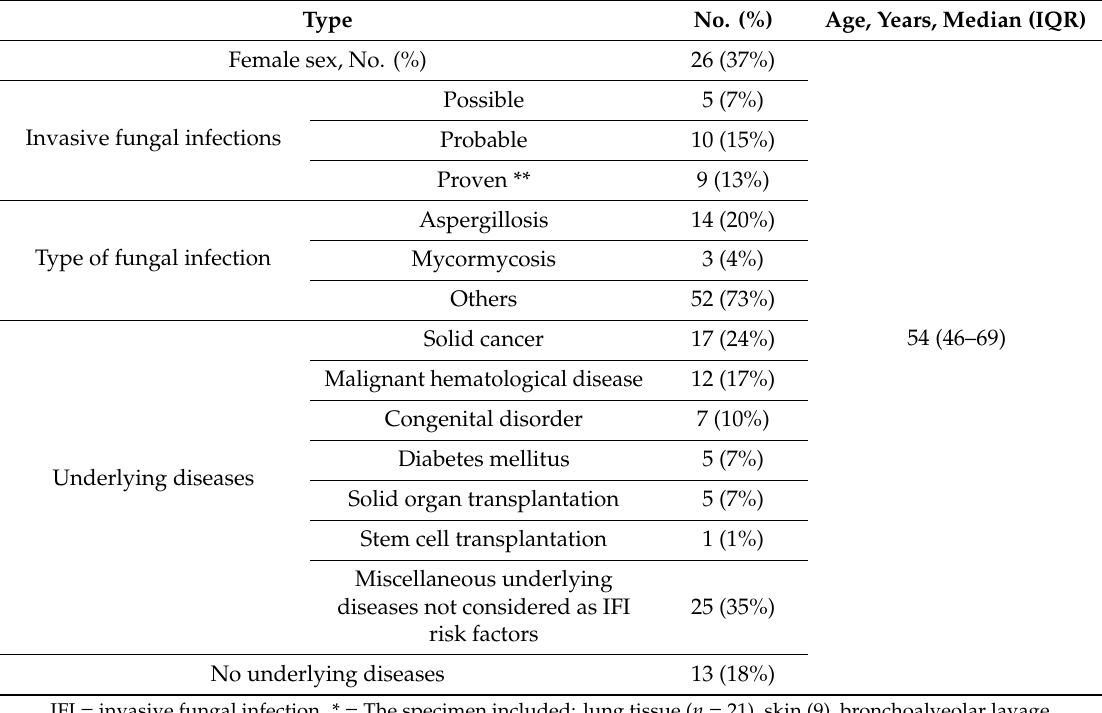
Table 1. Demographics of 71 patients, providing 81 samples * for